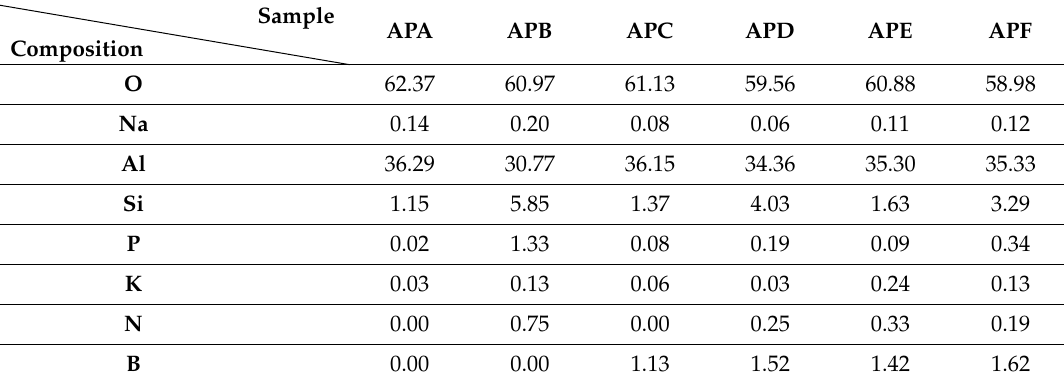
Table 2. Chemical compositions of PEO coatings analyzed by FE-EPMA (unit: at. %).